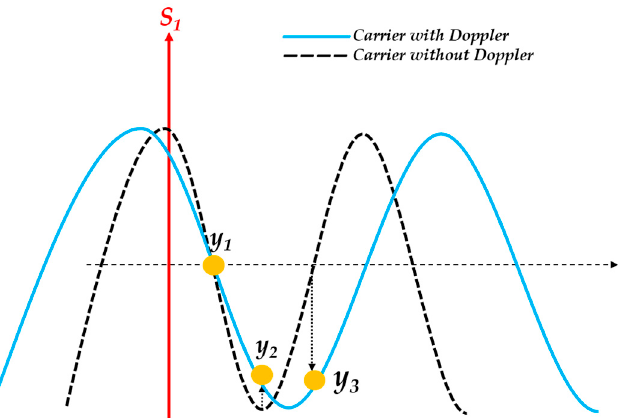
ϕ = π . Figure 6. The positions of three actual detection points ( y = π / 2 y 1 1